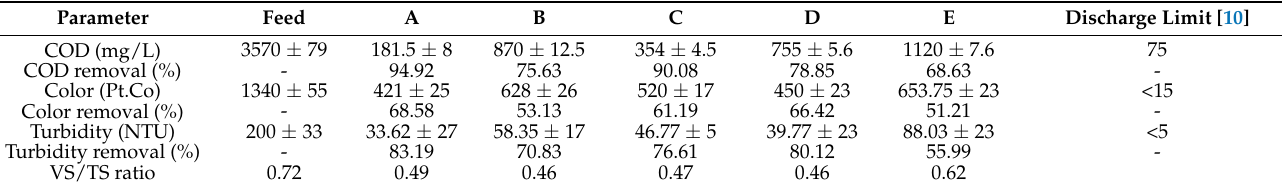
Table 1. Decontamination efficiency of the bioreactors